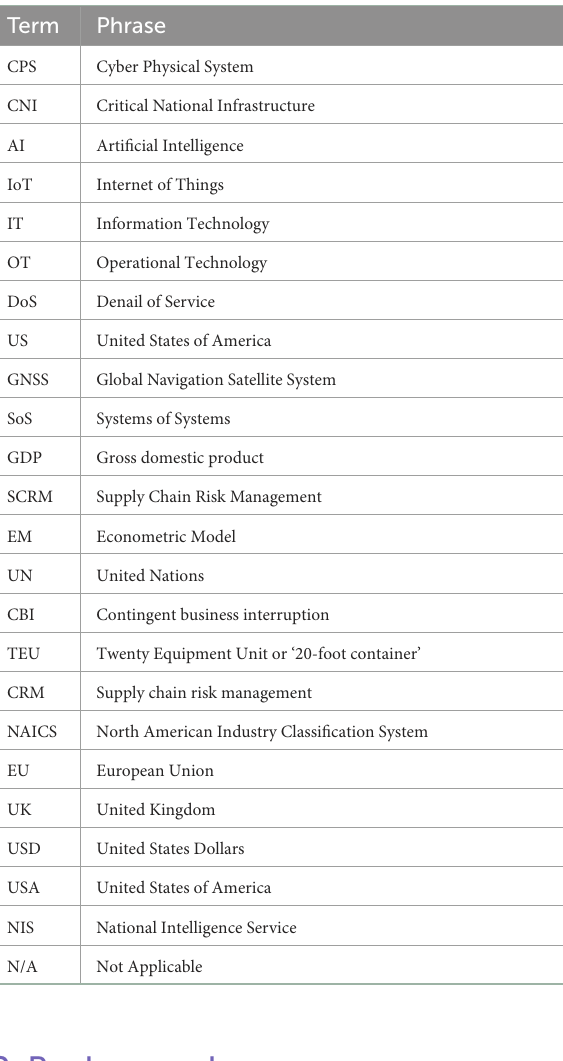
TABLE 1 Key abbreviations in order of